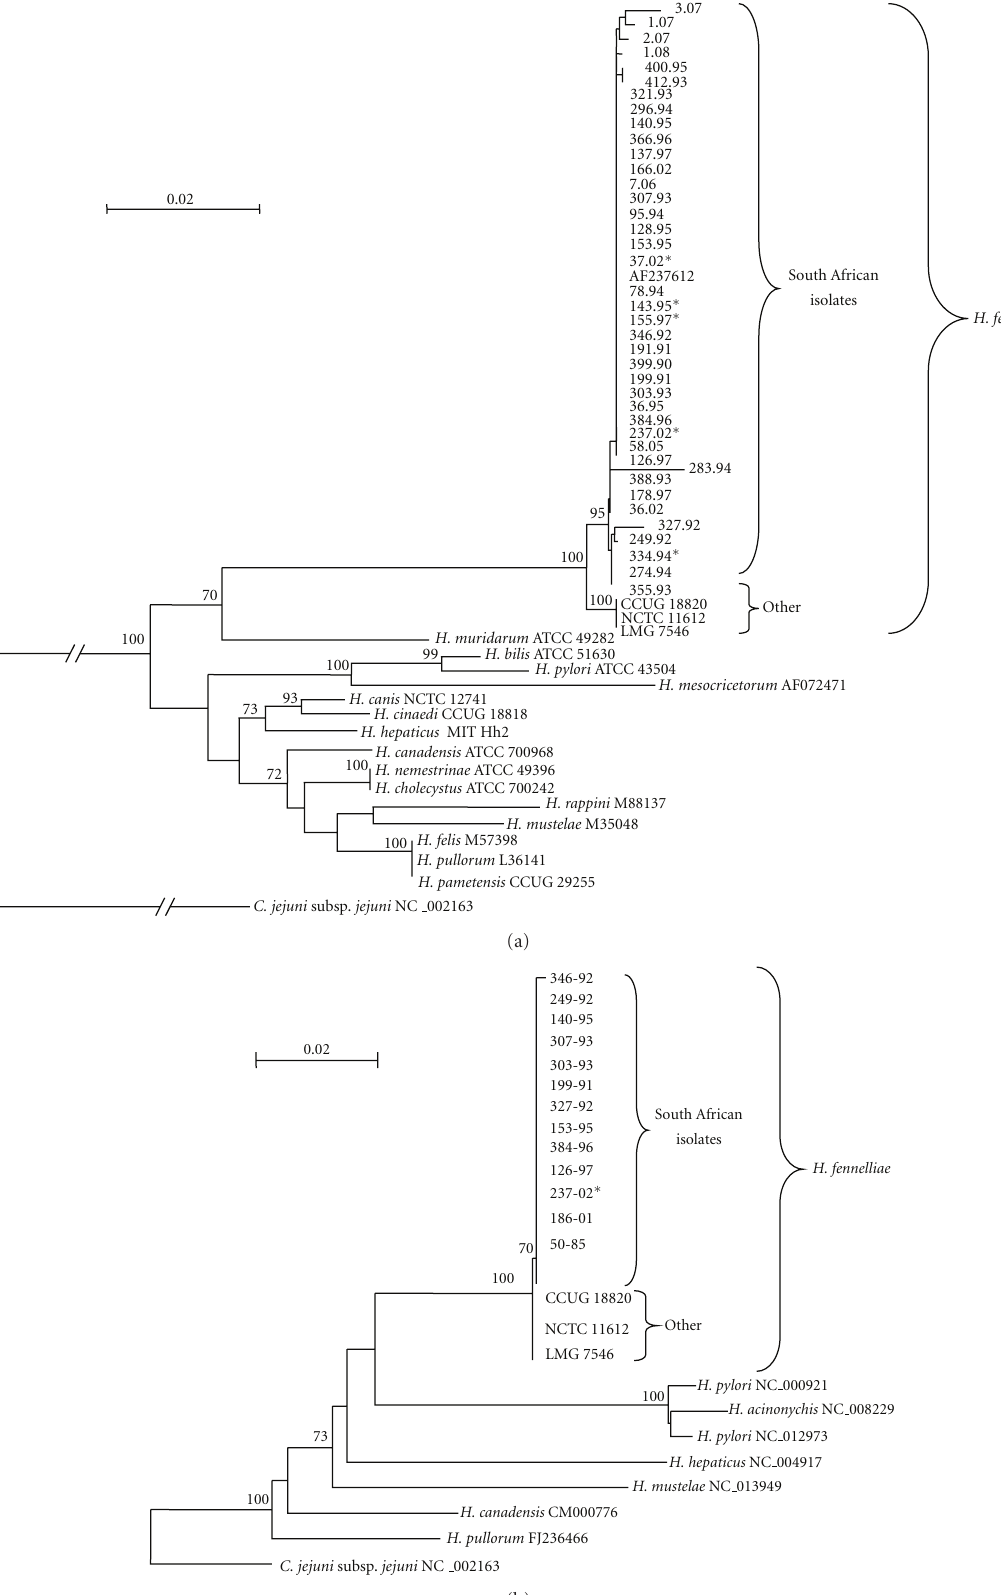
Figure 2: Phylogenetic trees of the 16S rRNA (a) and rpoB gene (b) of H. fennelliae and other Helicobacter species. ∗ indicates blood culture